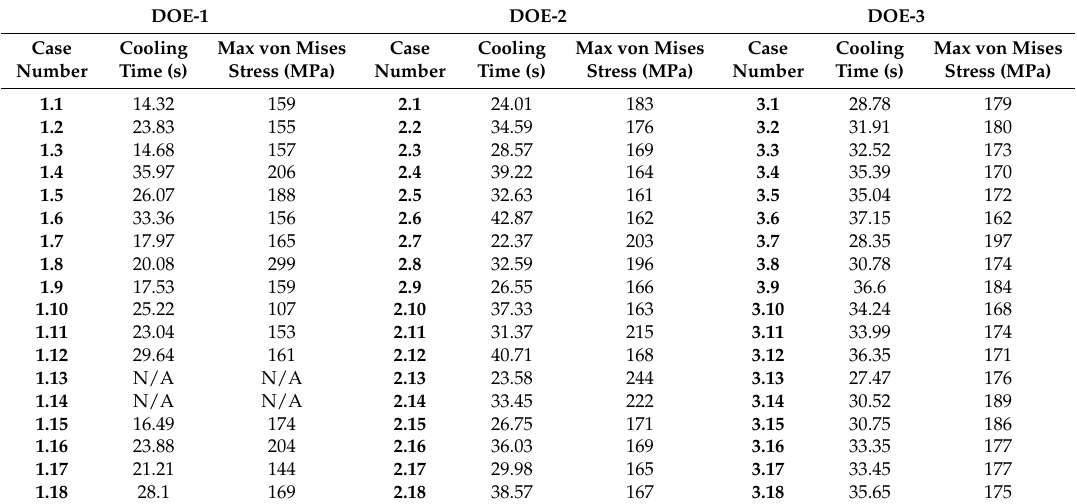
Table 5. DOE 1, 2 and 3 thermal and structural results.